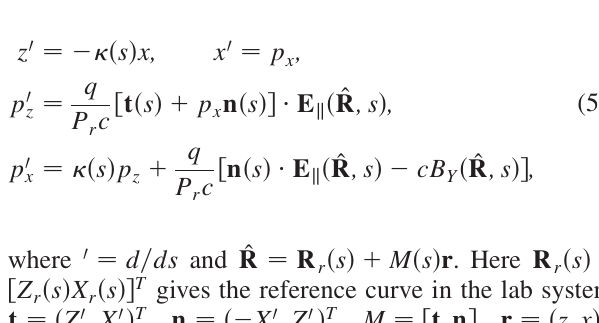
FIG. 17. The same as in Fig. 16 for the x emittance. The agreement is quite satisfactory. The final values of the x emit- tance are almost the same.